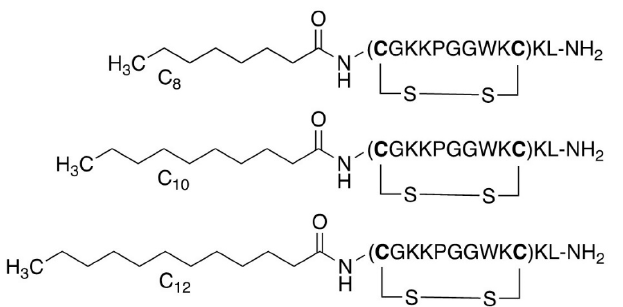
Figure 2. Lipopeptide modifications exemplified for cTurg-1 lipopeptides containing C 8 , C 10 and C 12 fatty